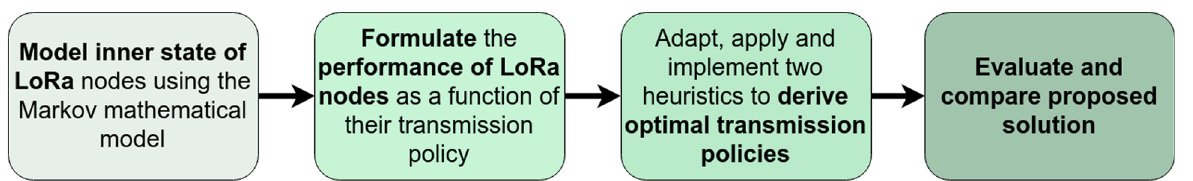
Fig. 1 Methods employed. Methods employed for the derivation of optimal policies in LoRa